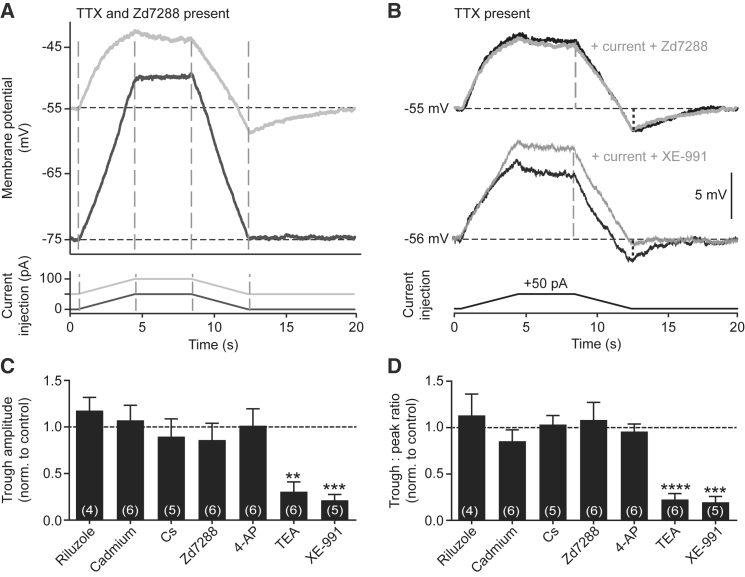
IKr Underlies Hyperpolarization Induced by Excitatory Input Withdrawal in ChIs(A) Representative membrane potential in presence of TTX (1 μM) and Ih blocker Zd7288 (50 μM) without (dark gray) and with (light gray) resting membrane potential (RMP) restored to −55 mV (n = 6) during trapezoid current injections.(B) Representative membrane potential in presence of TTX (black) and either (gray) Ih blocker Zd7288 or Kv7.2/7.3 blocker XE-991 (100 μM, n = 6). RMP was held at pre-drug condition.(C and D) Mean ± SEM of amplitude of hyperpolarization below RMP (C) or ratio of trough:peak (black versus gray vertical dashed lines in B) (D), normalized to control. Riluzole, 100 μM; cadmium, 200 μM; CsCl, 2 mM; Zd7288, 50 μM; 4-AP, 1 mM; TEA, 20 mM. n = 4–6. Typical traces shown in Figure S3. ∗∗∗p < 0.001, one-sample t test versus control.